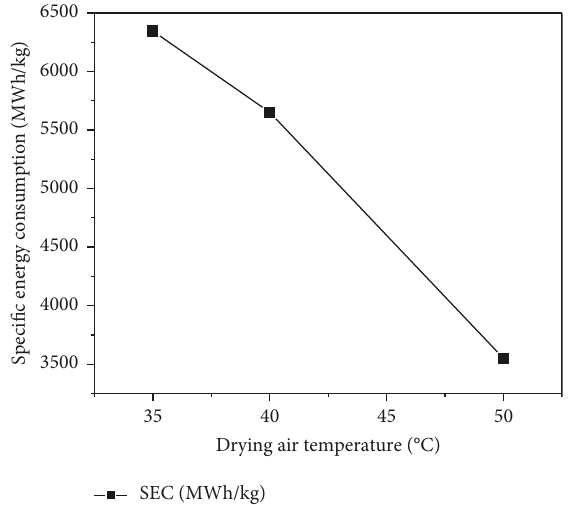
Figure 10: The evolution of the SEC versus drying air